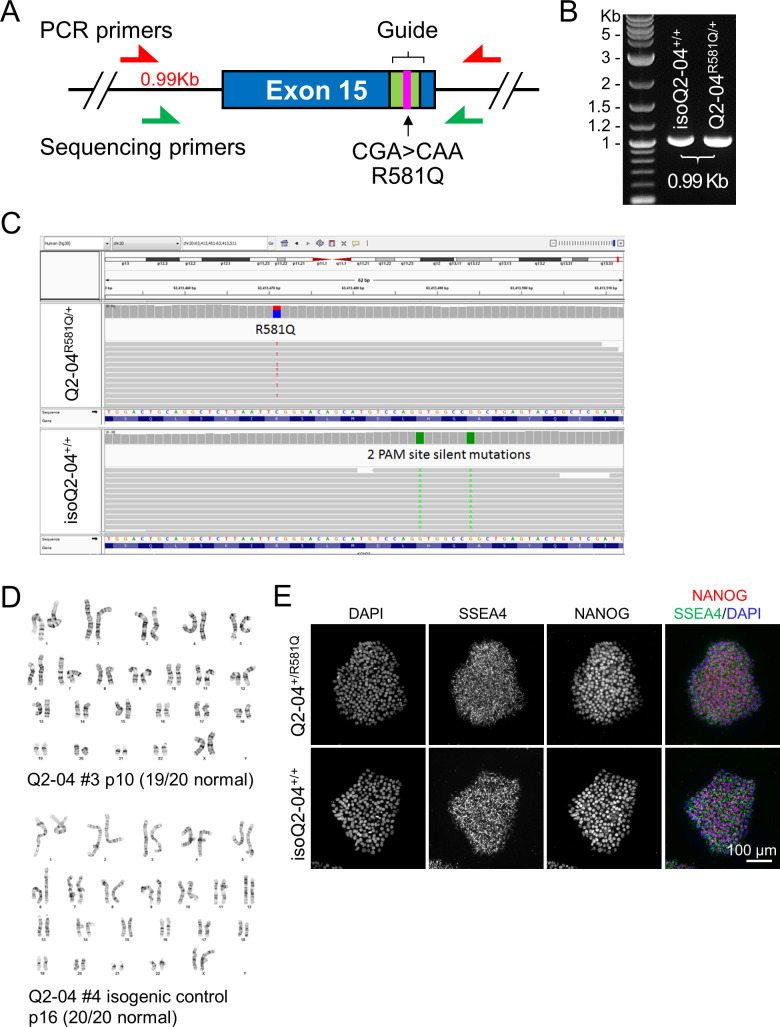
Quality control studies of iPSC lines.(A–B) Analysis of KCNQ2 targeted region after CRISPR/Cas9 gene correction. To validate the absence of large indels or mosaicism, a 0.99 Kb DNA fragment of genomic DNA around the targeted site was amplified and subjected to Sanger sequencing (Figure 1D). Products from both the parental and corrected iPSC lines exhibited one band of the expected size. (C) Karyotype analysis of patient and isogenic control iPSC lines. (E) Whole genome sequencing analysis of patient and isogenic control iPSCs. Integrated genomic viewer (IGV) showing 100 bp region around the patient mutation on exon 15 of KCNQ2 shows heterozygous R581Q mutation in the patient sample (top). Bottom: the mutation is corrected in the isogenic control sample. Also, two silent PAM site mutations were introduced in the isogenic control (in green). (G) Immunocytochemical labeling of Q2-04R581Q/+ and isogenic control (isoQ2-04+/+) iPSC lines with the pluripotency markers NANOG, SSEA4 and DAPI. Scale bar: 100 µm.